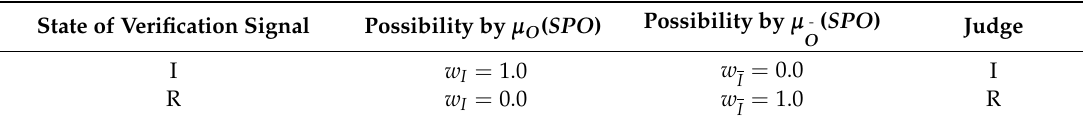
Table 9. Diagnosis results based on Rule 2 of fuzzy inference Table 8. Diagnosis results based on the Rule 1 of fuzzy inference